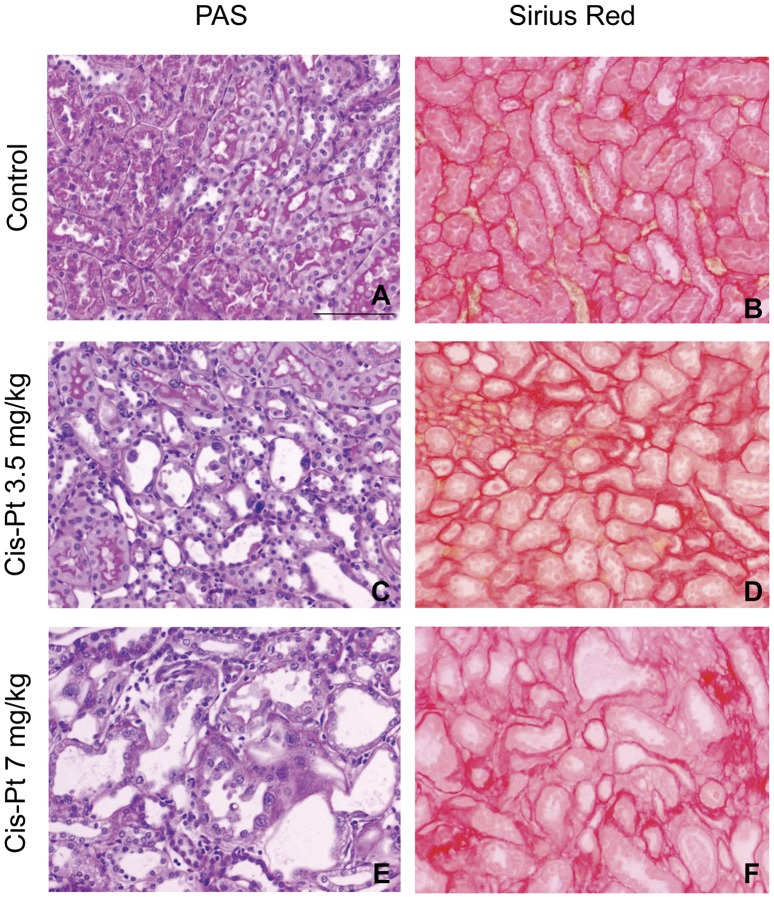
Morphological changes and tubulointerstitial fibrosis in renal outer medulla induced by cisplatin.Left panel shows control group without morphological lesion (A), CisPt3.5 (C) and CisPt7 (E) groups whit moderate nuclear dysplasia, incipient acute tubular necrosis, marked tubular dilation and apoptotic cells in tubular lumen of proximal convoluted tubules in the corticomedullary junction (PAS original magnification x200). Scale bar  = 100 micrometers. Right panel shows representative photographs of Sirius red staining of kidneys from control (B), 3.5 (D) and 7 mg/kg cisplatin-treated rats (F) after 14 days (original magnification x200).